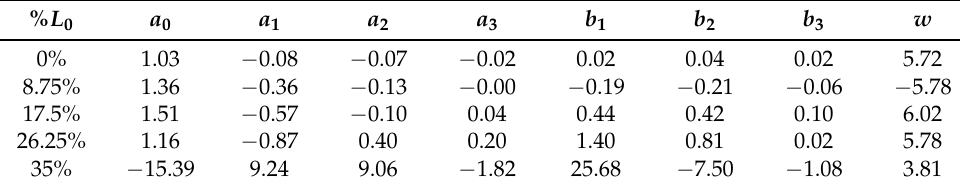
Table 3. Coefficient values for the three-term Fourier Series fit performed in Figure